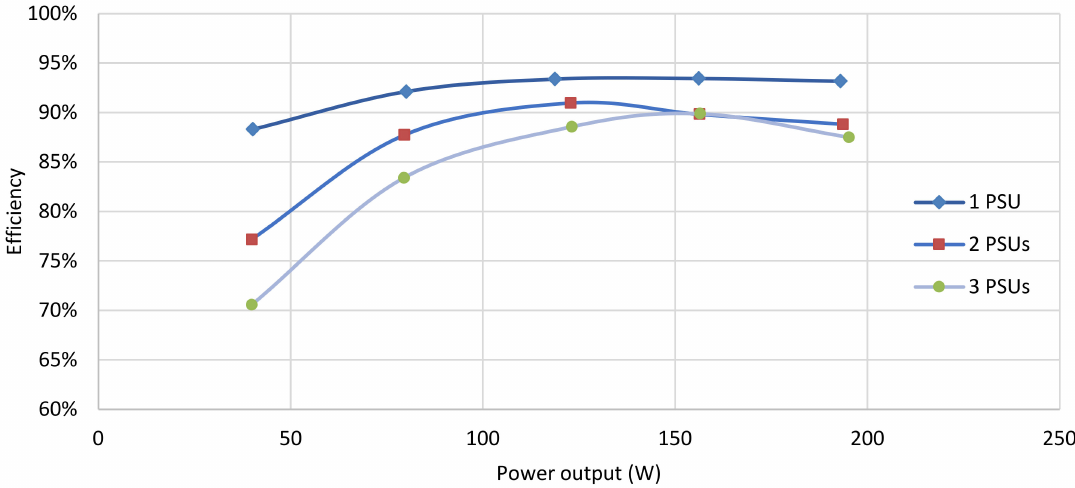
Figure 10. Efficiency against power output of 1, 2 and 3 PSUs working in parallel (with transformer).